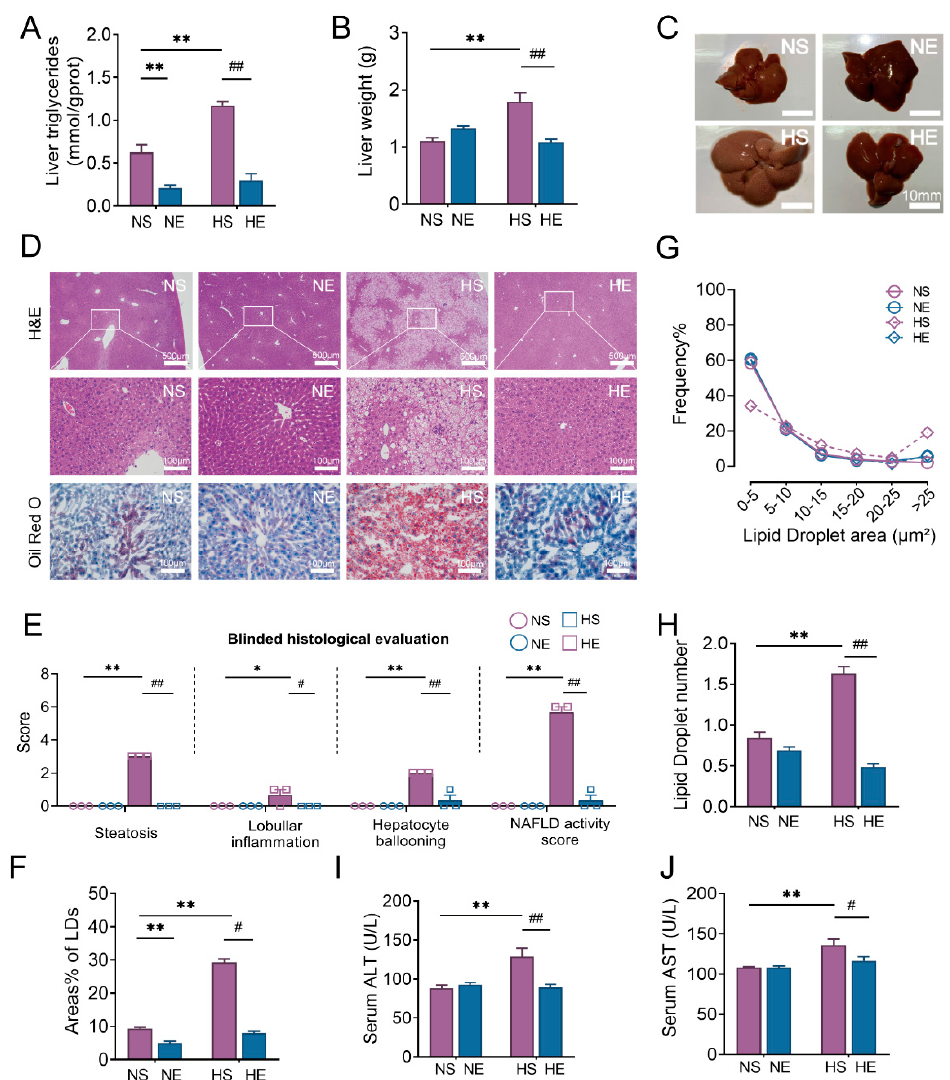
Figure 3. Exercise training suppresses the development of NAFLD in HFD mice. ( A , B ) Liver weight and triglycerides. ( C , D ) Representative macroscopic morphology, H&E, and Oil red O staining in the liver from each group (scar bar: 10 mm for macroscopic morphology, scar bar: 500 µ m and 100 µ m for H&E staining, scar bar: 100 µ m for Oil red O staining) ( n = 3). ( E – H ) The analysis of NAFLD activity score and Oil red O staining ( n = 3). ( I,J ) serum ALT and AST. Unless otherwise specified, six mice per group were used in each experiment. The data are expressed as mean ± SEM. * p < 0.05, ** p < 0.01 versus NS mice; # p < 0.05, ## p < 0.01 versus HS mice.